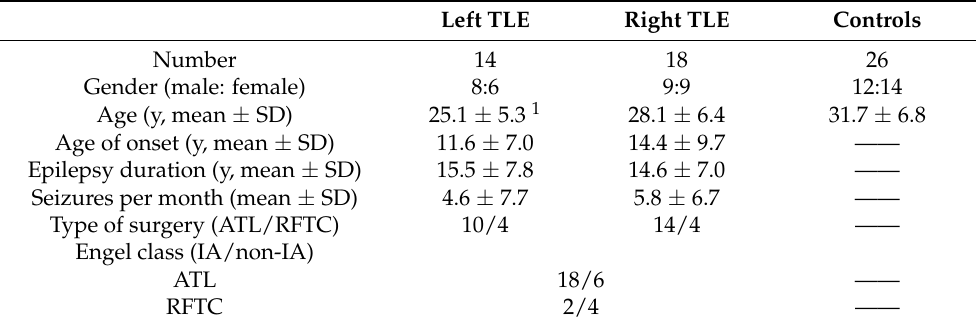
Table 1. Demographic and clinical characteristics of